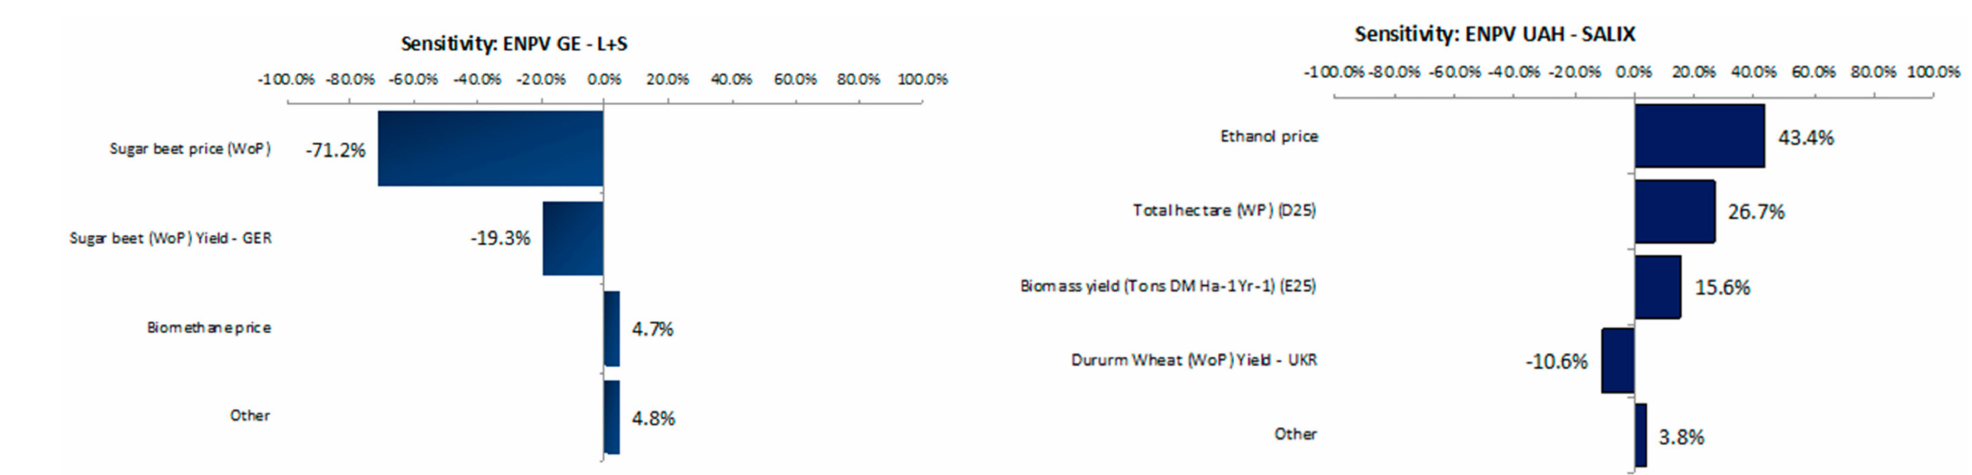
Figure A3. Tornado plot sensitivity analysis of selected investments.